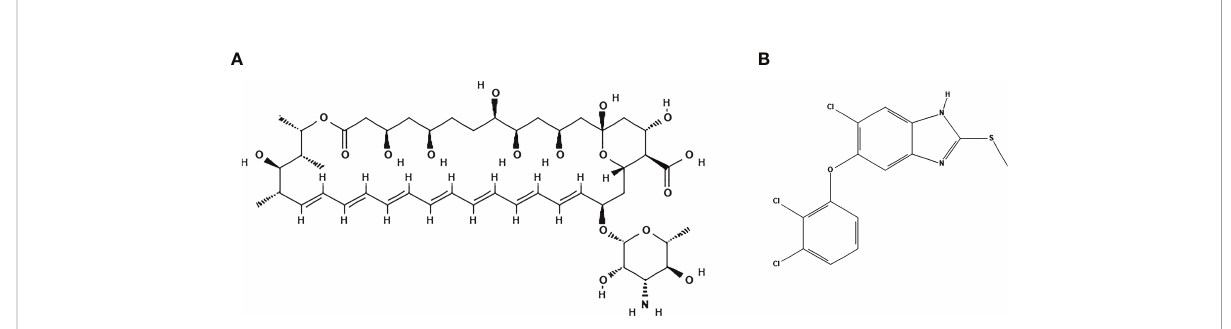
FIGURE 1 Structures of Amphotericin B and Triclabendazole. (A) Amphotericin B presents a molecular formula of C 47 H 73 NO 17 (PubChem CID: 5280965). (B) Triclabendazole presents a molecular formula of C 14 H 9 C l3 N 2 OS (PubChem CID: 50248). Structures were generated by PubChem (National Center for Biotechnology